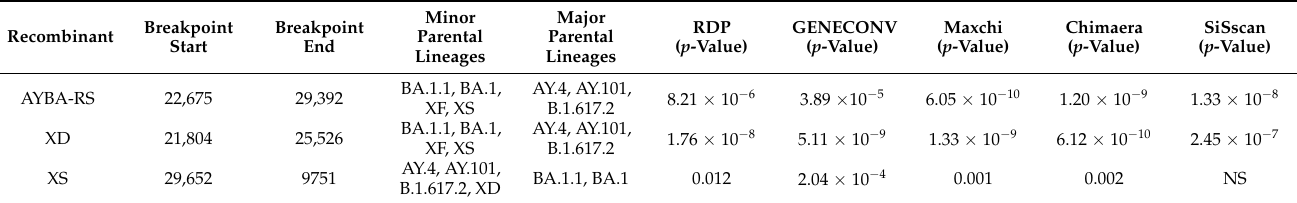
Table A3. Recombination analysis of Deltacron variants (RDP4 output).